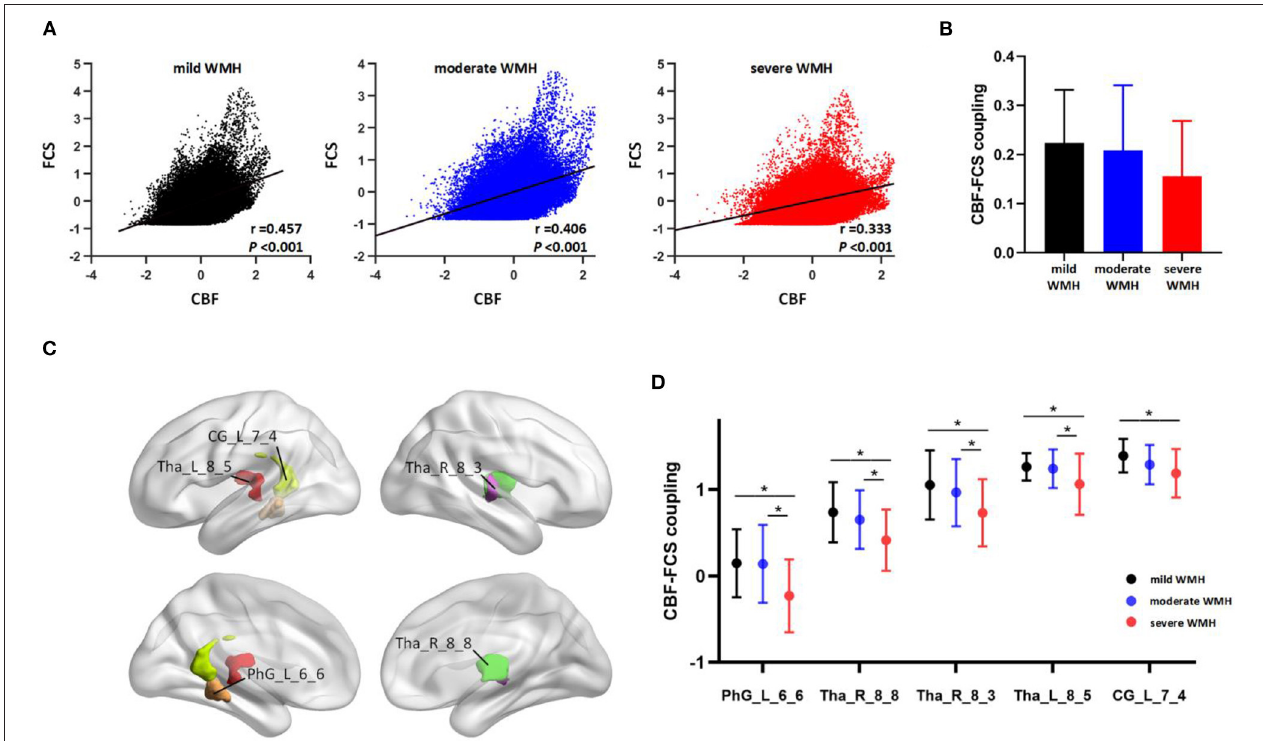
FIGURE 4 | Global and regional CBF–FCS coupling changes among subjects with different WMH loads. (A) Whole-brain CBF–FCS coupling alterations across voxels in samples of subjects with different WMH loads. (B) Between-group comparisons exhibited a decreasing trend in global CBF–FCS coupling from mild WMH group to severe WMH group (mild WMH group: r = 0.225 ± 0.108; moderate WMH group: r = 0.209 ± 0.132; severe WMH group: r = 0.156 ± 0.112), whereas no significant differences were identified in global CBF–FCS coupling among three WMH groups ( F = 1.645, p = 0.199). (C,D) Altered regional CBF–FCS coupling among three WMH groups. Compared with mild WMH and moderate WMH group, severe WMH group showed significant aberrant CBF–FCS coupling in bilateral thalamus, ACC, and left parahippocampal gyrus. Data were shown as adjusted correlation coefficients between CBF and FCS controlling for age and sex. Error bars represent the SD. * p < 0.05. ACC, anterior cingulate cortex; PhG, parahippocampal gyrus; Tha, thalamus; WMH, white matter hyperintensities. L, left; R, right. Detailed information on brain regions is available at